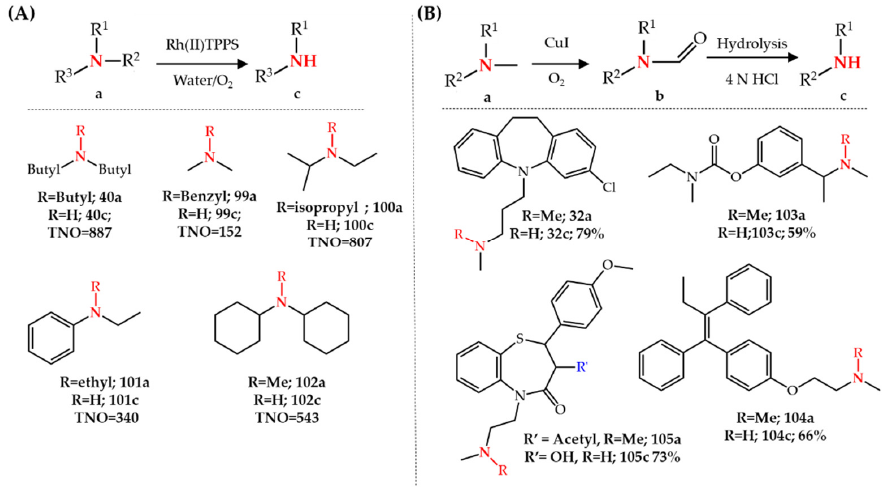
Figure 15. ( A ) Rhodium ‐ catalyzed and ( B ) copper ‐ catalyzed N ‐ dealkylation of amines. Genovino et al. [118,119] reported a Cu ‐ catalyzed oxidation of tertiary amines in